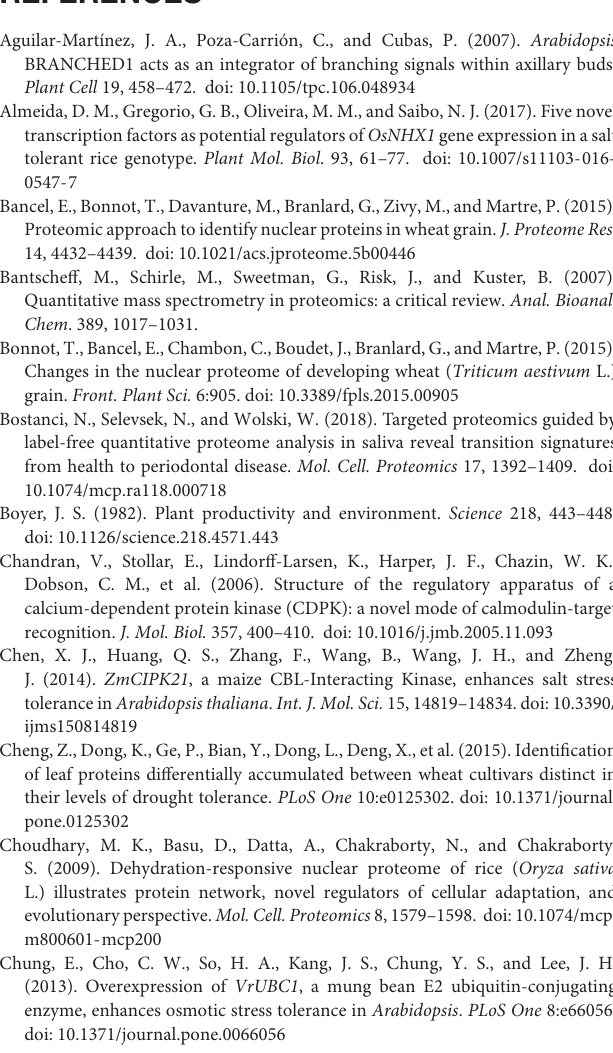
Supplementary Table 1 | The list of peptides identified from extracted nucleus of wheat developing grains under water deficit.